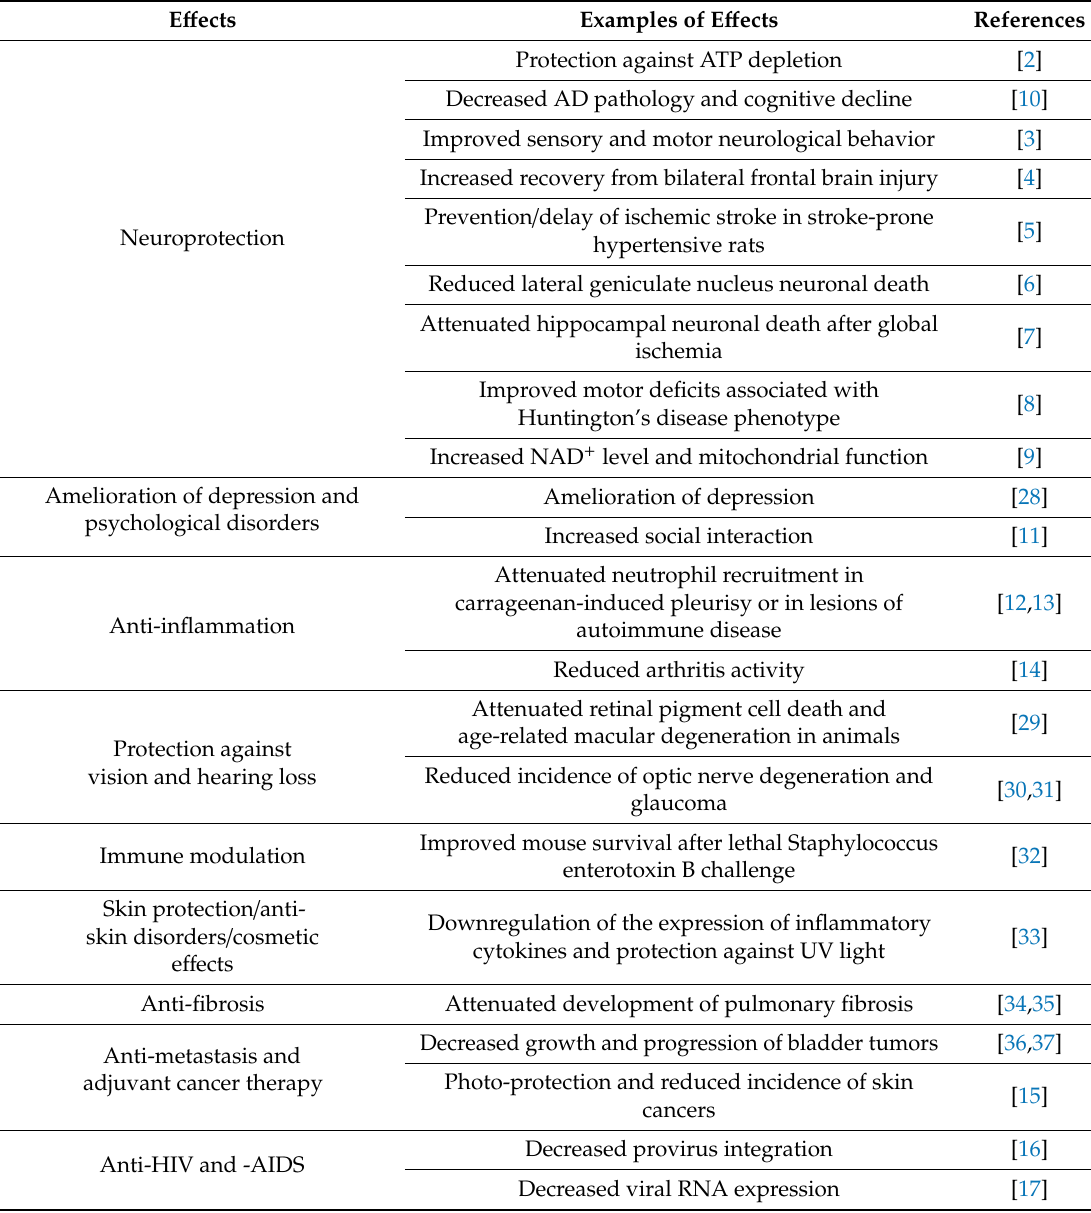
Table 1. Summary of beneficial e ff ects of high doses of nicotinamide (NAM). E ff